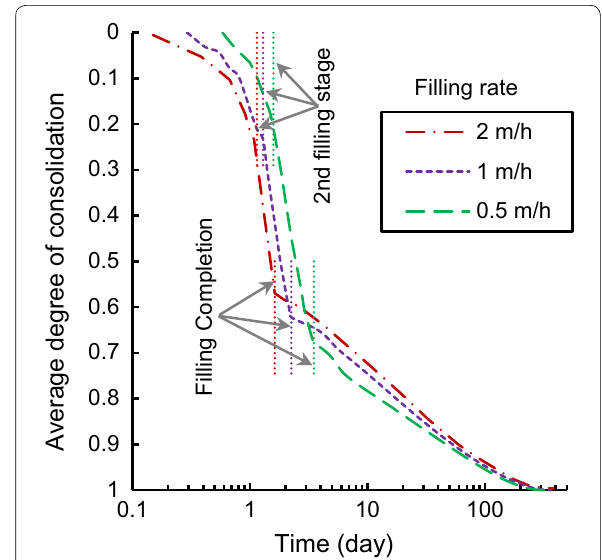
Fig. 18 Effect of cement content on the consolidation process of Fig. 19 Effect of filling rate on consolidation process of CPB